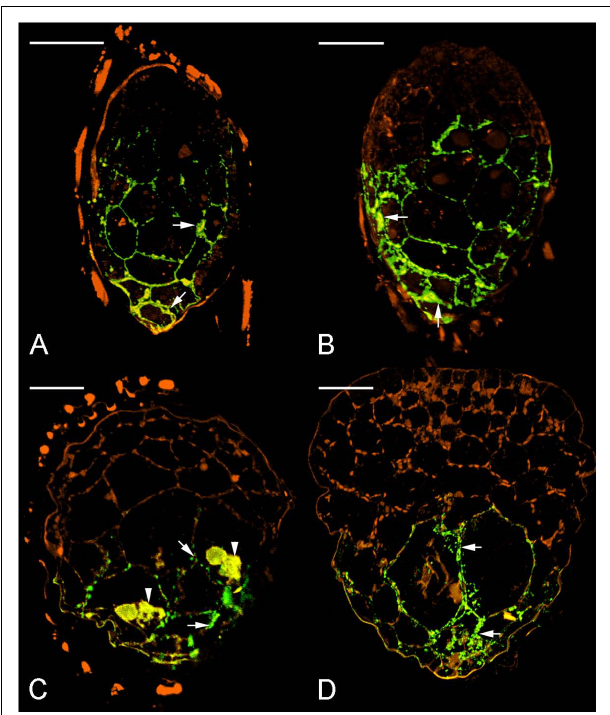
FIGURE 6 | Immunofluorescence localization of JIM11 epitope during symbiotic seed germination of D. officinale . (A) The uncolonized embryo with strong signals of JIM11 epitope (green color, excitation 488 nm and emission 500–530 nm). The signals (arrows) are present mainly in the walls of the middle and basal regions of the embryo. The orange color indicates the autofluorescence (excitation 488 nm and emission 565–615 nm). Scale bar = 50 µ m. (B) After 1 week of inoculation, the infected embryo showing strong signals of JIM11 epitope (arrows) in the walls of the middle and basal regions of the swollen embryo. Scale bar = 50 µ m. (C) After 2 weeks of inoculation, the enlarged embryo with the rupture of the seed coat showing prominent signals of JIM 11 epitope in the pelotons (arrowheads) and the walls of colonized cells (arrows) in the basal protocorm. Scale bar = 50 µ m. (D) After 3 weeks of inoculation, the signals of JIM 11 epitope (arrows) are mainly observed in the walls of colonized cells of the developing protocorm. Scale bar = 100 µ